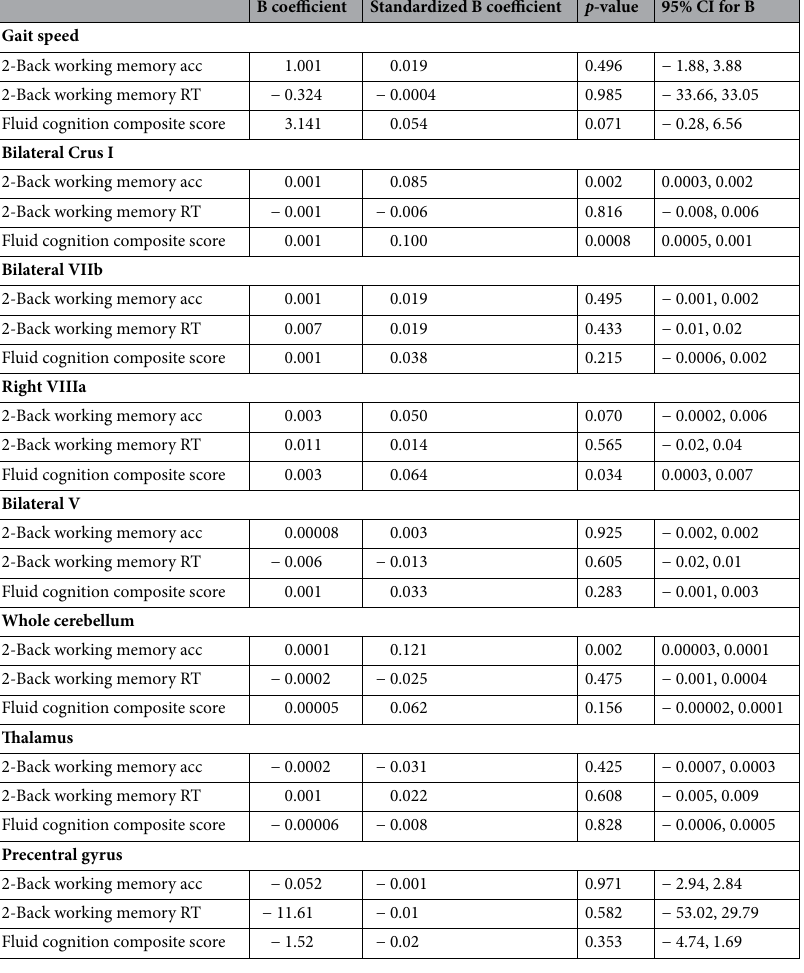
Table 2. Association between cerebellar subregion volumes/gait speed and working memory performance. The thalamus volume and precentral gyrus thickness were measured as control. 95% CI, 95% confidence interval, PSQI used as a continuous variable; regression analyses were adjusted for age, sex, education year, and ICV for cerebellar subregions; regression analyses were adjusted for age, sex, and education year for gait speed; ACC, accuracy; RT, response time.